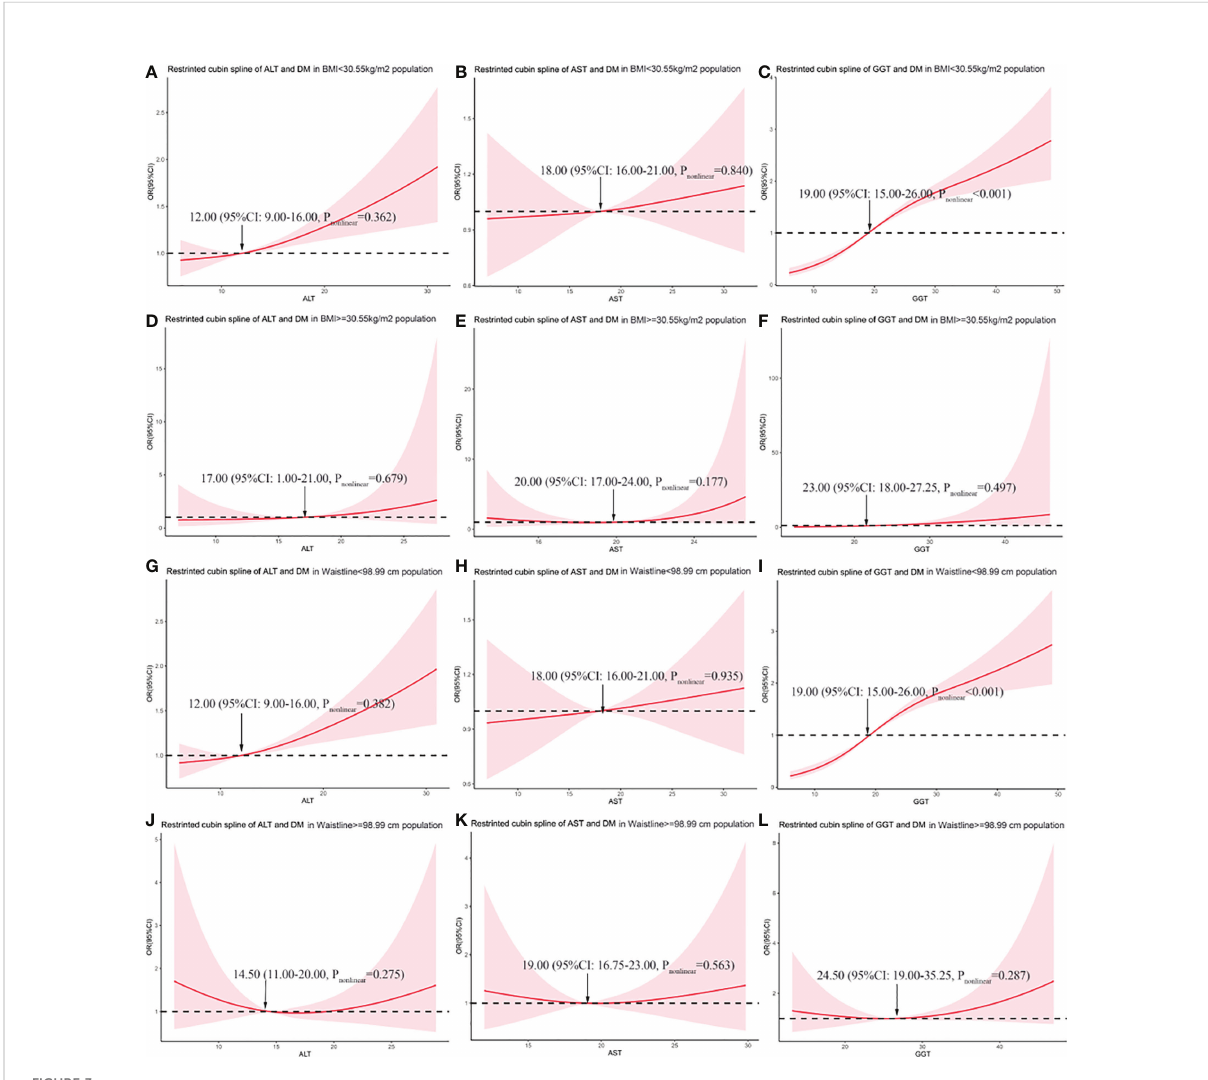
FIGURE 3 The association between liver enzymes and the risk of diabetes in different BMI and WC subgroups. (A) Association between alanine aminotransferase (ALT) and odds ratio (OR) in the subgroup with BMI <30.55 kg/m 2 . (B) Association between aspartate aminotransferase (AST) and OR in the subgroup with BMI <30.55 kg/m 2 . (C) Association between gamma-glutamyl transferase (GGT) and OR in the subgroup with BMI <30.55 kg/m 2 . (D) Association between ALT and OR in the subgroup with BMI ≥ 30.55 kg/m 2 . (E) Association between AST and OR in the subgroup with BMI ≥ 30.55 kg/m 2 . (F) Association between GGT and OR in the subgroup with BMI ≥ 30.55 kg/m 2 . (G) Association between ALT and OR in the subgroup with WC <98.99 cm. (H) Association between AST and OR in the subgroup with WC <98.99 cm. (I) Association between GGT and OR in the subgroup with WC <98.99 cm. (J) Association between ALT and OR in the subgroup with WC ≥ 98.99 cm. (K) Association between AST and OR in the subgroup with WC ≥ 98.99 cm. (L) Association between GGT and OR in the subgroup with WC ≥ 98.99